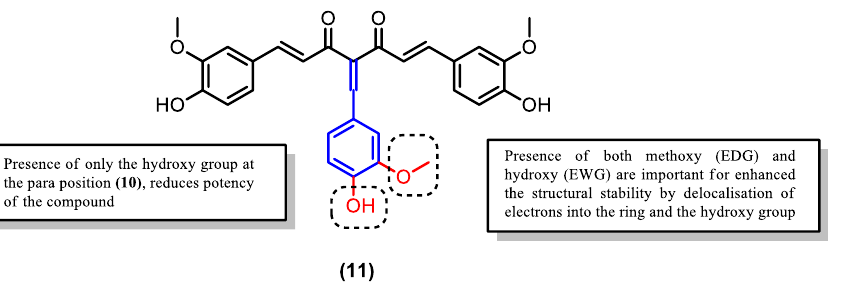
Figure 16. Structure of curcumin derivative ( 11 ) with both EDG and EWG groups attached to the additional phenyl.